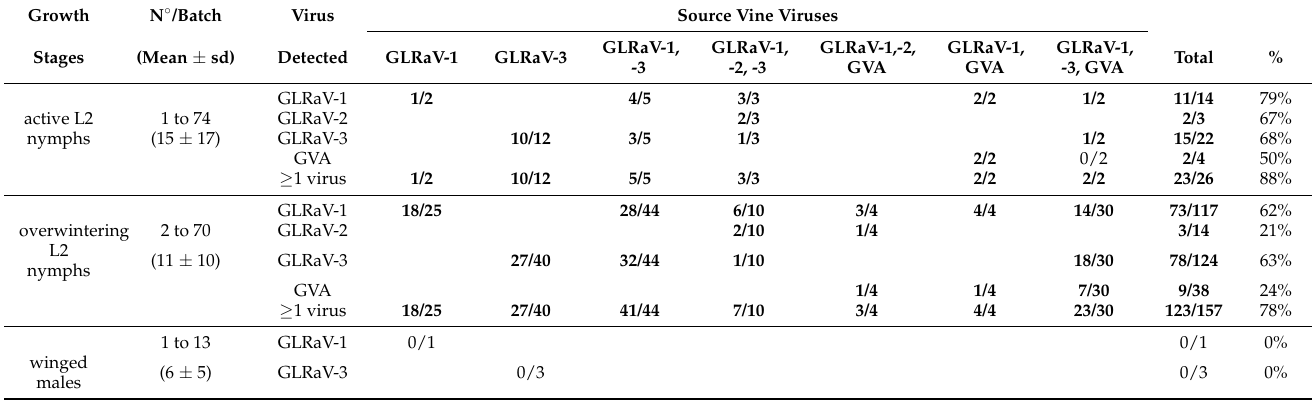
Table 3. Virus detection by RT-PCR in batches of Heliococcus bohemicus L2 nymphs and adult males collected on different infected vines in vineyards. Detection rates for each virus according to virus combinations in source vines = number of positive nymph batches/number of batches tested. Positive detections are highlighted in bold.